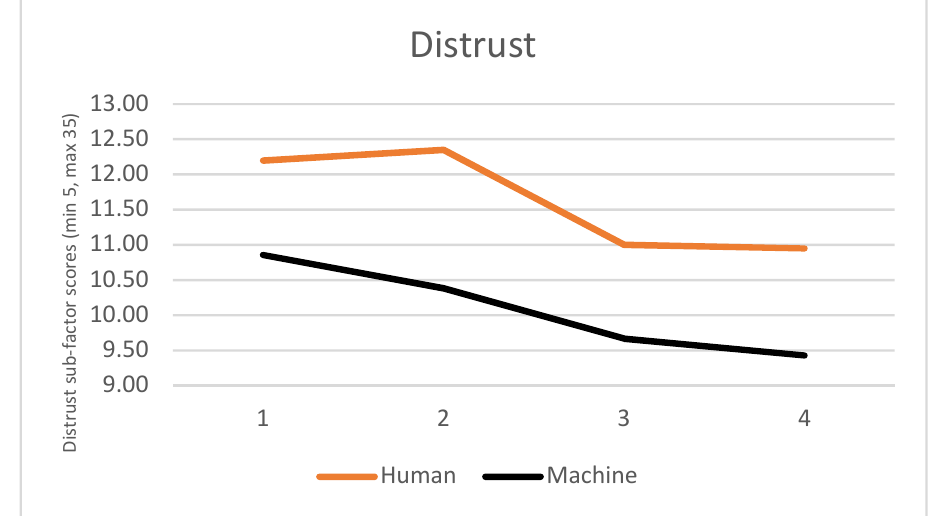
Figure 5. Distrust scores as a separated subset from [75].